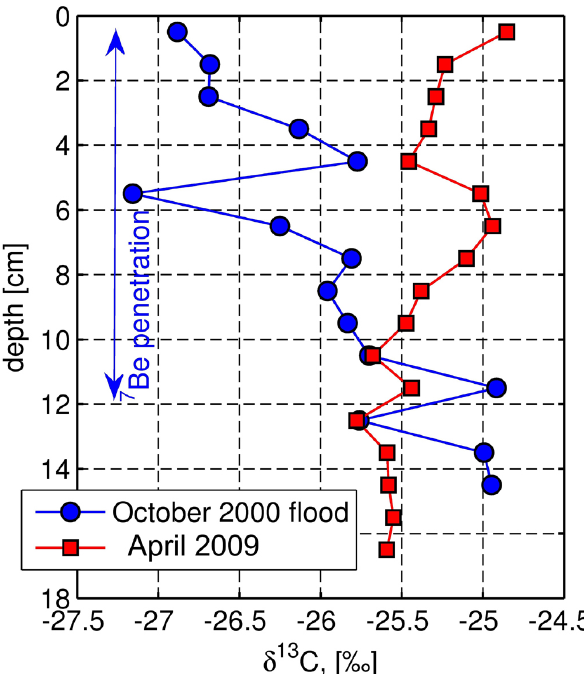
Fig. 7. Down-core profiles of δ 13 C. Filled circles show the N14 core collected in December 2000 (Miserocchi et al., 2007). Solid line shows the 7 Be penetration (Palinkas et al., 2005) in December 2000. Filled squares show the N14 core collected on 30 April 2009. In this latter sediment core 7 Be was not